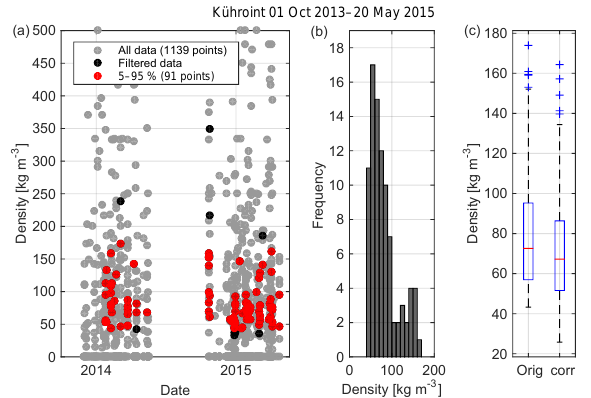
Figure 4. Distribution of calculated new snow densities at Kühroint station for period 1 (1 October 2013–20 May 2015). (a) All data have a precipitation signal and positive HS change, all data are fil- tered with HN>2cm, HNW>1.5mm, T w <0 ◦ C and u <5ms − 1 ) and filtered data are reduced by cutting off at 5 and 95% percentiles. (b) Histogram of all filtered densities. (c) The box plot showing the median and 25 and 75% interquartile range of uncorrected densi- ties and densities corrected for settling of the snowpack. Note that similar figures are available in the Supplement (Figs. S10–S17) for all stations and all time periods considered in this study.